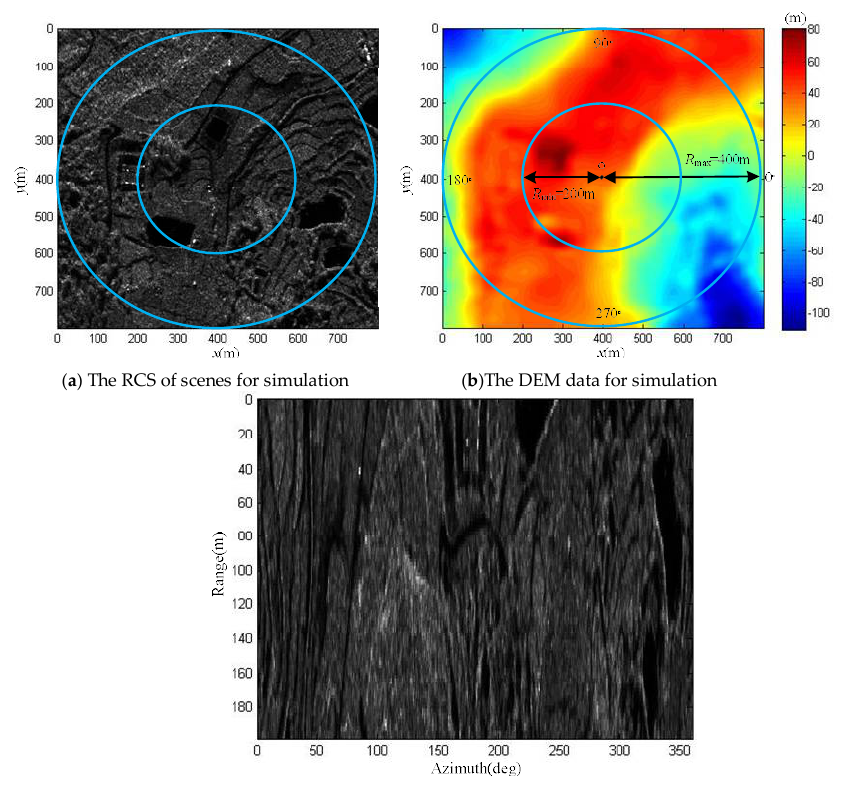
Figure 18. The RCS scenes for simulation, the DEM data for simulation and the simulated ArcSAR image in polar coordinate system. image in polar coordinate